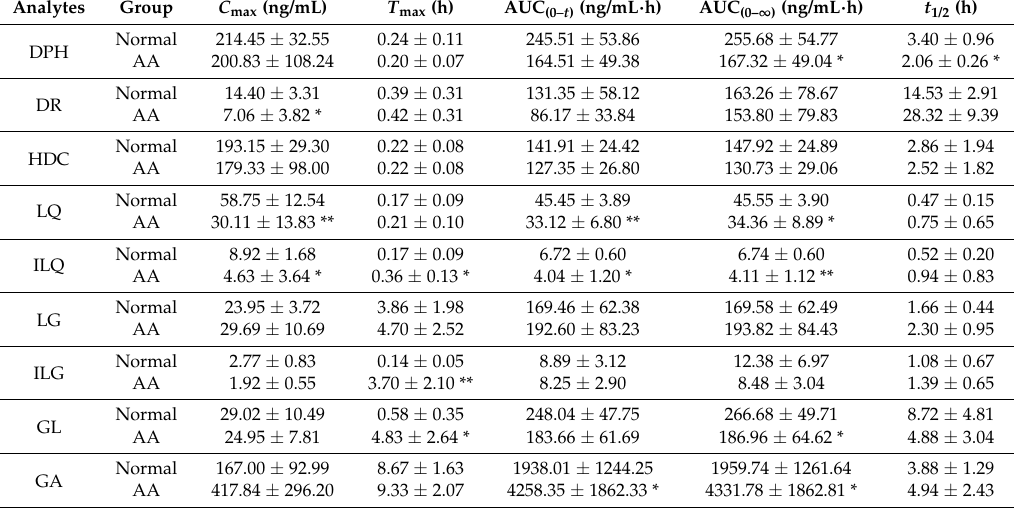
Figure 2. Time–concentration profiles of nine components in plasma from normal ( ) and AA ( ) rats after oral administration of Zushima-Gancao extract. The upper right corner of each drug curve shows the corresponding drug profile within 1 h. Abbreviation notes: DPH: daphnetin; DR: daphnoretin; HDC: 7-hydroxycoumarin; LQ: liquiritin; ILQ: isoliquiritin; LG: liquiritigenin; ILG: isoliquiritigenin; GL: glycyrrhizin; GA: glycyrrhetinic acid. Table 5. The pharmacokinetic parameters of DPH, DR, HDC, LQ, ILQ, LG, ILG, GL, and GA in normal and AA rats after oral administration of Zushima-Gancao extract to rats ( n = 6, mean ± SD). Analytes